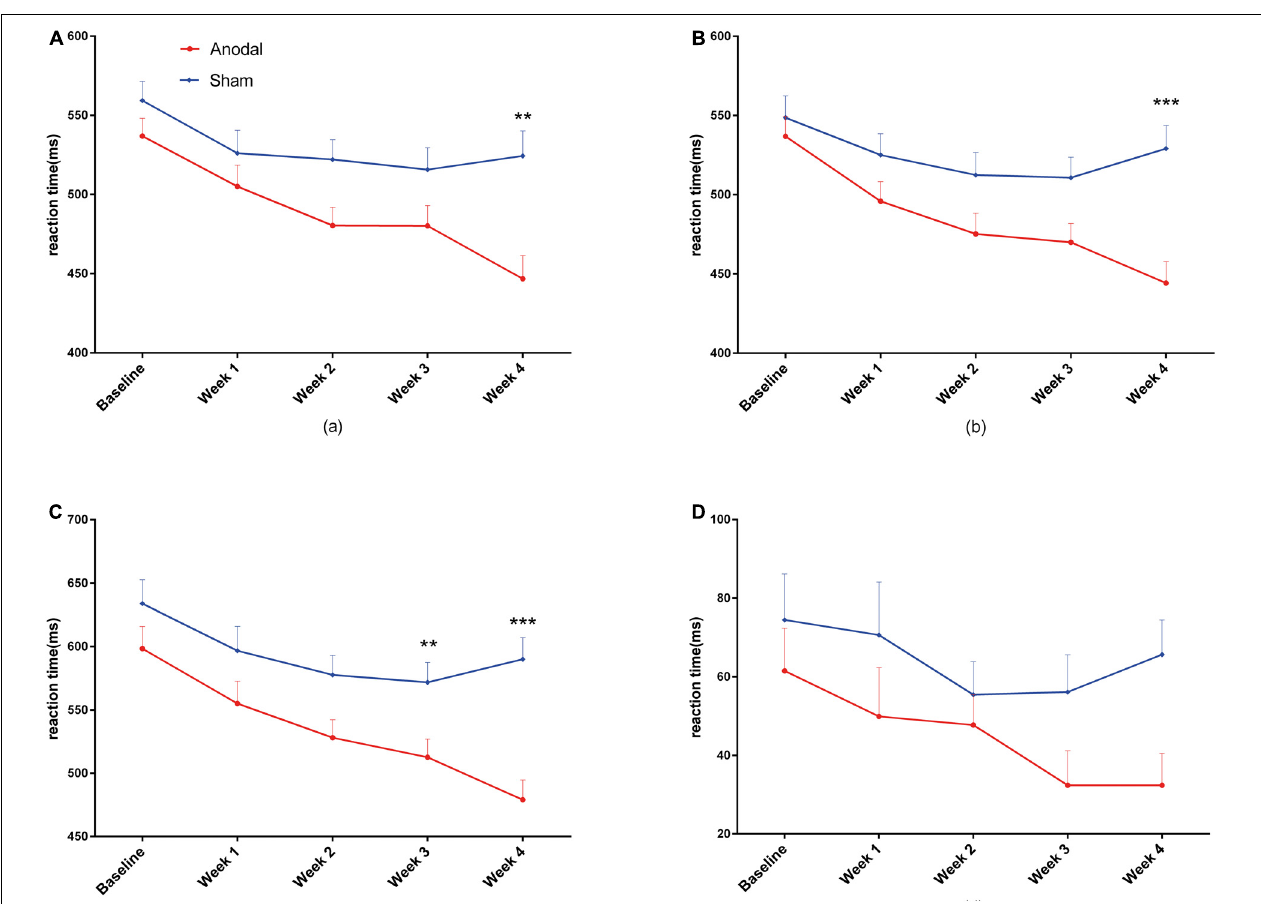
FIGURE 6 | Variation in reaction time during CW-Stroop from baseline to week 4 in the anodal group and the sham group ( A = neutral, B = congruent, C = incongruent, D = Stroop effect). Error bars indicate the SEM for the change in reaction time. ** P < 0.01, *** P < 0.001, comparison between two groups.